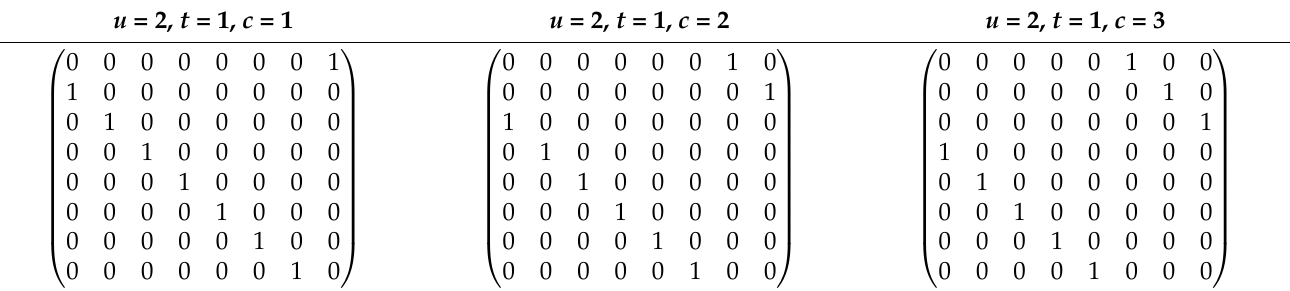
Table 7. Quantum premium gates.